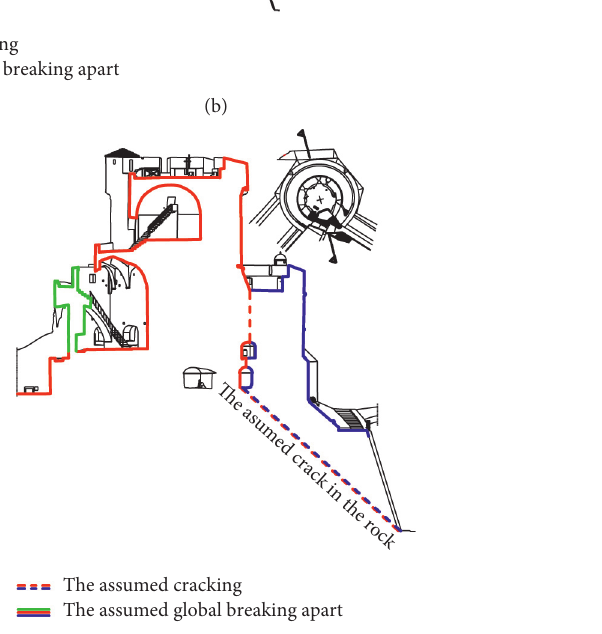
Figure 14: The assumed global cracking pattern, breaking apart, and sliding rock surface. (a) The overlapping of the corridors and casemates at the zero and first levels. (b) The assumed global breaking apart of the fortress. (c) The assumed sliding rock surface and the breaking apart of the